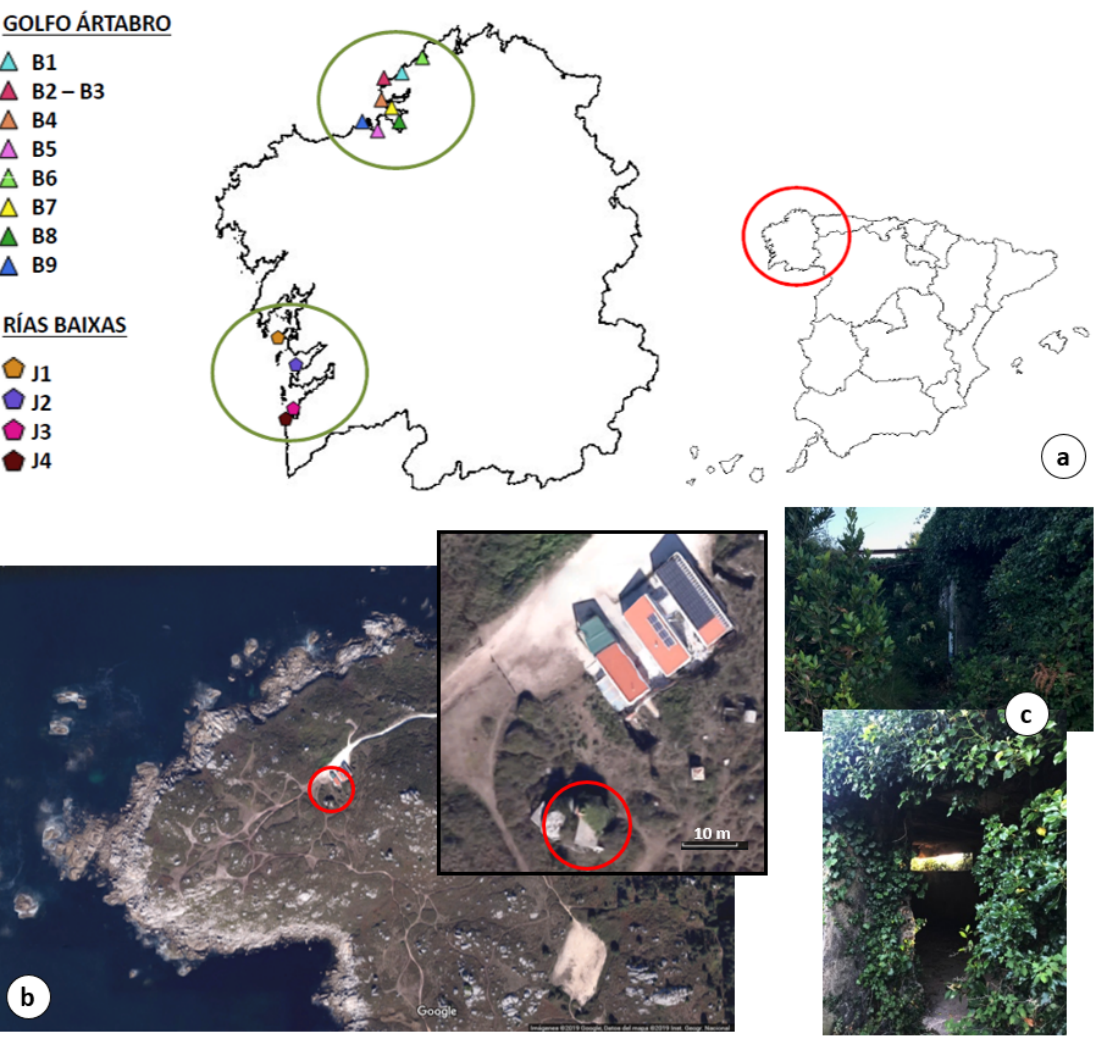
Figure 1. ( a ) Location of the military batteries in Galicia (northwest of Spain), ( b ) J-2 battery in Cabo Figure 1. a ) Location of the military batteries in Galicia (northwest of Spain), b ) J-2 battery in Cabo Udra (map images © 2019 Google, National Geographic Institute), and ( c ) exterior of the battery Udra (map images © 2019 Google, National Geographic Institute), and c ) exterior of the battery covered by covered by vegetation.